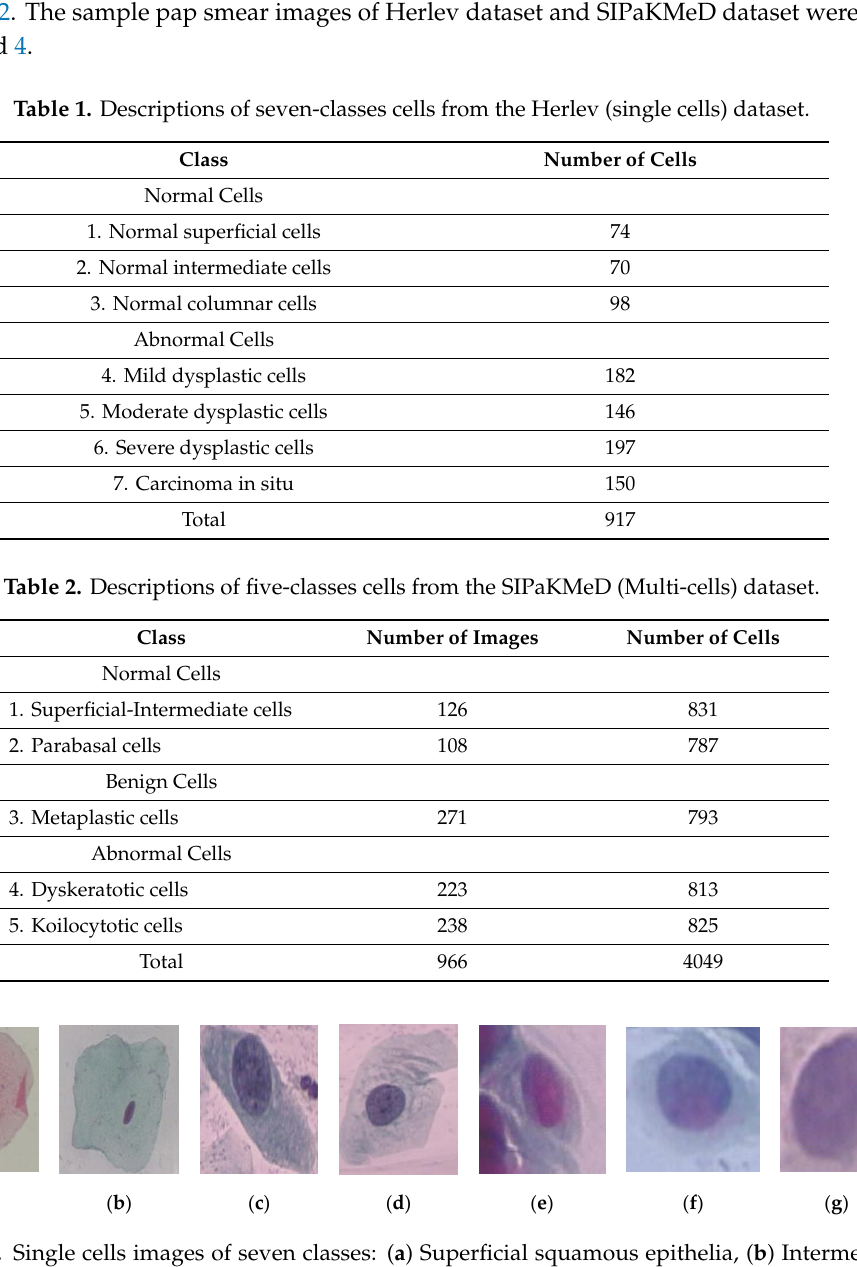
Table 1. Descriptions of seven-classes cells from the Herlev (single cells) dataset.